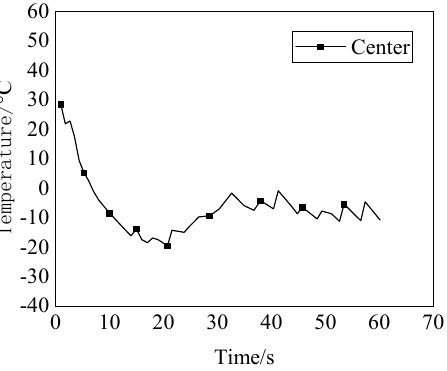
Figure 18. Variation curve of temperature in response phase with time under heat flux of 10,000 W/m 2 .